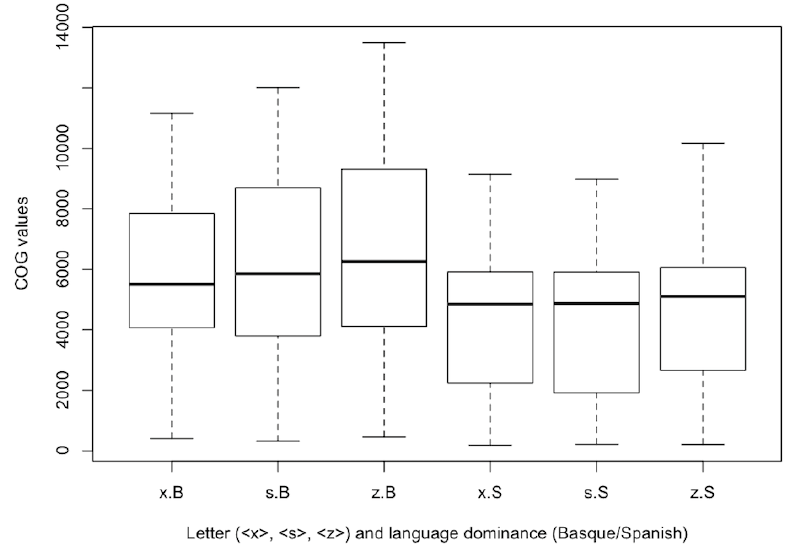
Figure 4. Boxplot with mean Center of Gravity (COG) by letter (<x>,
, and <z>) and language dominance (Basque and Spanish).